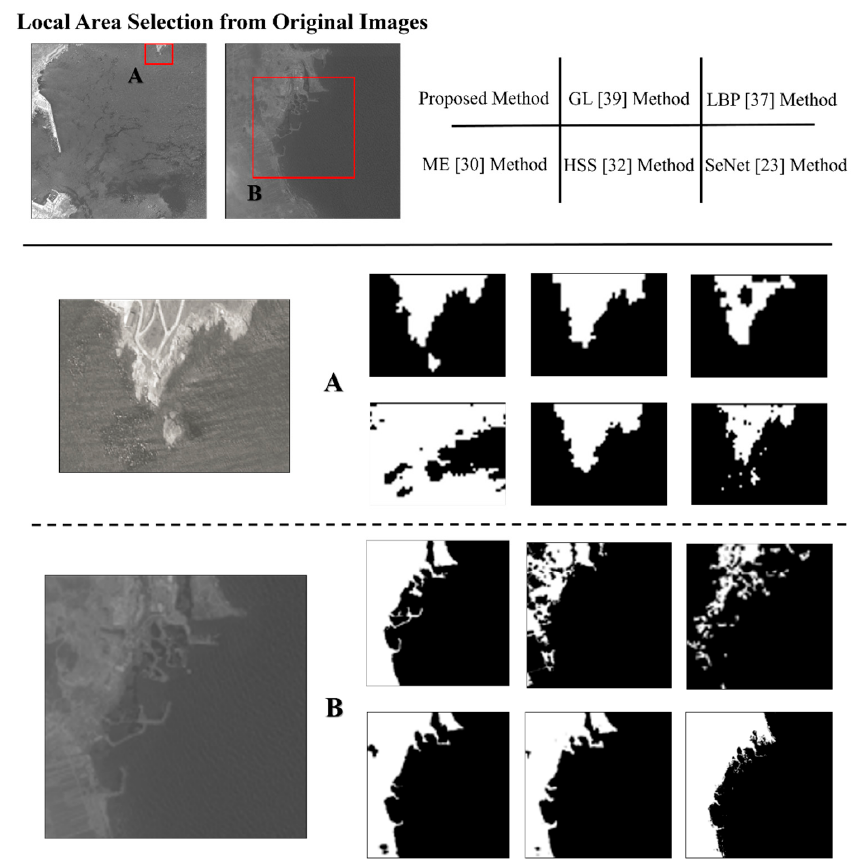
Figure 12. Analysis of refined water body extraction results for comparing methods. The top of figure shows detailed local boundary selection and results formation.